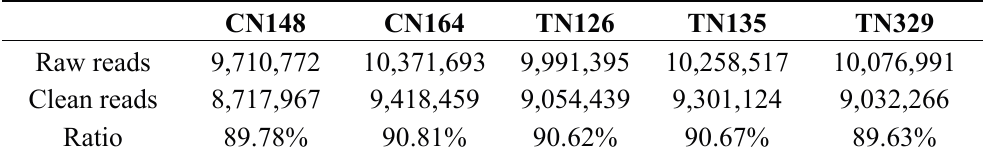
Table 1. The overview of raw RNA sequencing data in muscle samples of propeptide transgenic and control mice.